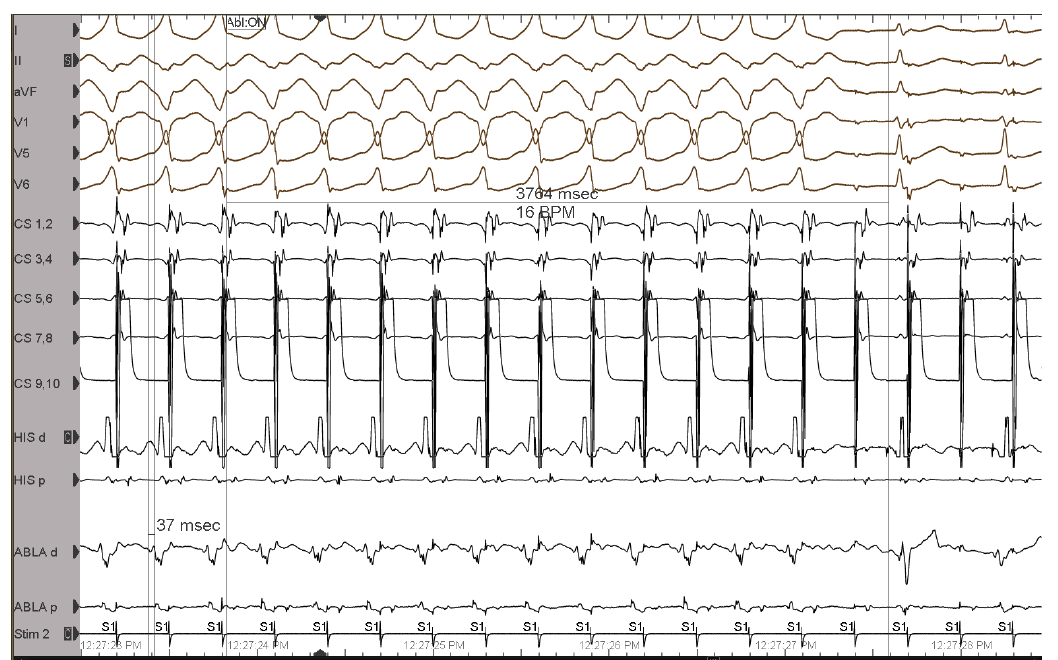
Figure 5. During full pre-excitation elicited by fast atrial pacing (CL 290 ms), radiofrequency appli- cation at the ventricular insertion of the accessory pathway induced a loss of pre-excitation in 3.5 s; ECG leads from the top: DI, DII, aVF, V1, V5, V6. His d and His p indicate distal and proximal His bundle electrogram; CS 1-10, coronary sinus distal to proximal; Abla d and p, ablation catheter distal and proximal, respectively, placed in the RV.